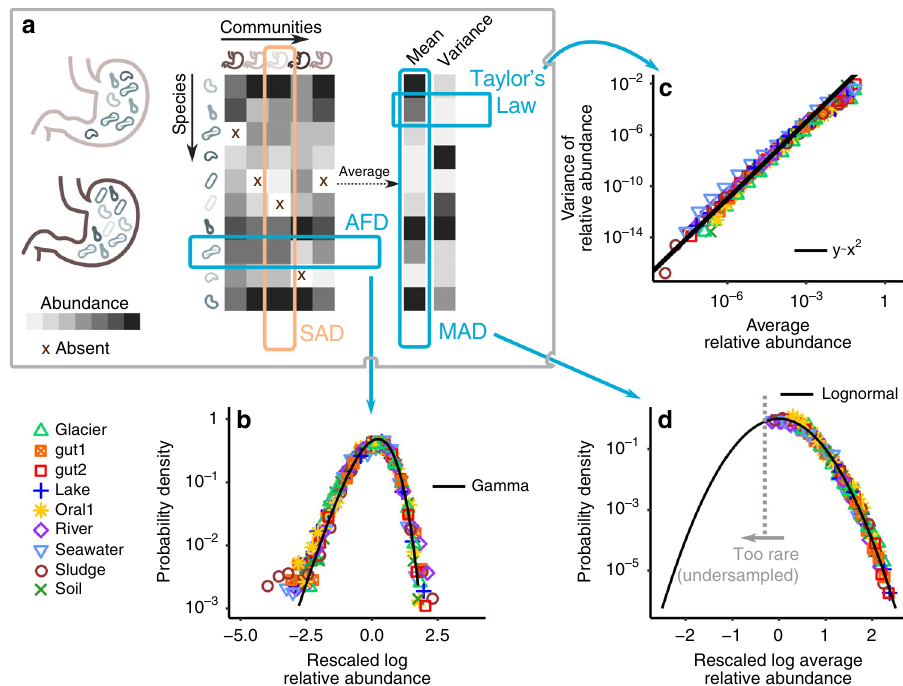
Fig. 1 Laws of variation in microbial communities. a The species abundance distribution (SAD) describes the fl uctuations of abundance across species in a community. b The Abundance Fluctuation Distribution (AFD) describes the distribution of abundances of a species across communities. I consider cross- sectional data from 9 data sets (colored symbols, see Methods). A Gamma distribution (solid black line) closely matches the AFD, here reported for the most abundant species (see Methods). The Gamma distribution describes the AFD of both abundant and rare species (Supplementary Note 1 and Supplementary Fig. 2). c The mean and variance of the abundance distribution are not independent across species, a relationship known as Taylor's Law. The variance is, in fact, proportional to the square of the mean (solid line), implying that the coef fi cient of variation of the abundance fl uctuations is constant across species (Supplementary Fig. 7). Taylor's Law (together with a Gamma AFD) implies that a single parameter per species (the average abundance) recapitulates the distribution of fl uctuations. d The Mean Abundance Distribution (MAD), de fi ned as the distribution of mean abundance (obtained by averaging over communities) across species, is Lognormally distributed (black line, Supplementary Note 7).